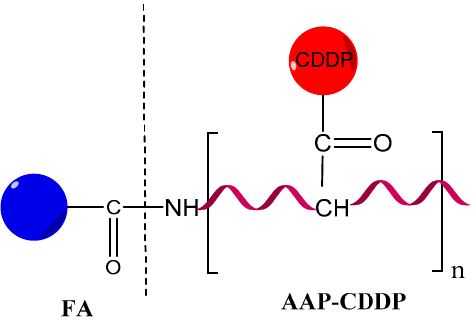
Figure 14. FA-AAP-CDDP polymeric complex.